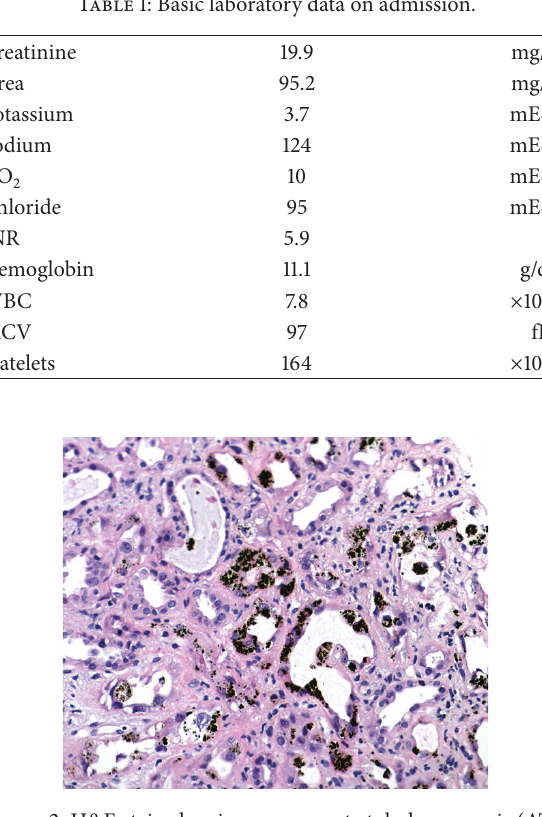
Figure 2: H&E stain showing severe acute tubular necrosis (ATN) caused by extensive iron depositions in the tubules (H&E, × 300).